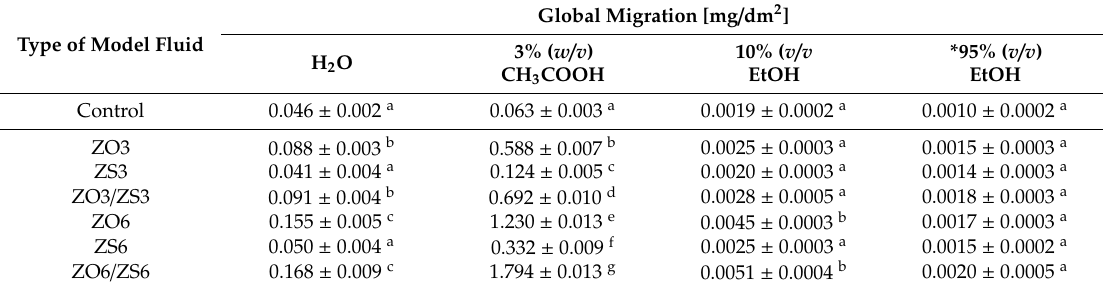
Table 3. Comparison the results of global migration of PE films containing a masterbatch with zinc oxide (ZO) and / or zinc stearate (ZS) ( n = 3, p < 0.05).